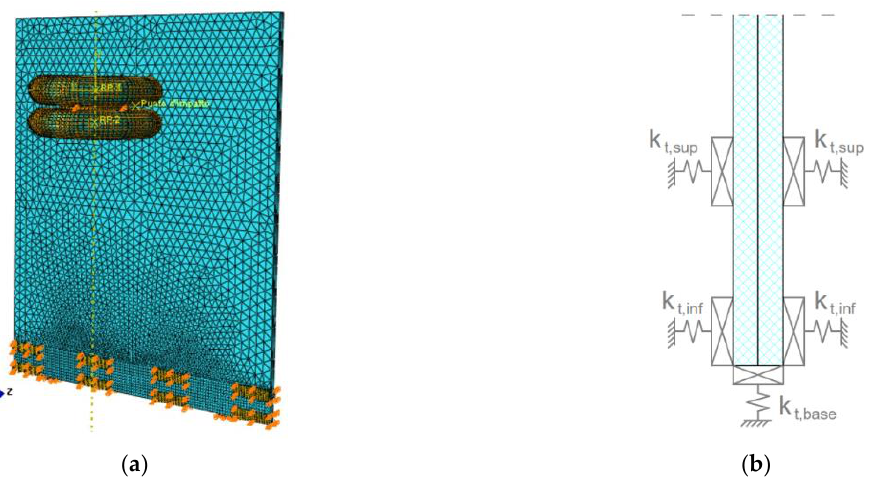
Figure 7. SM1 simplified model: ( a ) model concept and 3D assembly (axonometric view from ABAQUS), with ( b ) the reference mechanical system (cross-section) and evidence of lumped equivalent springs.